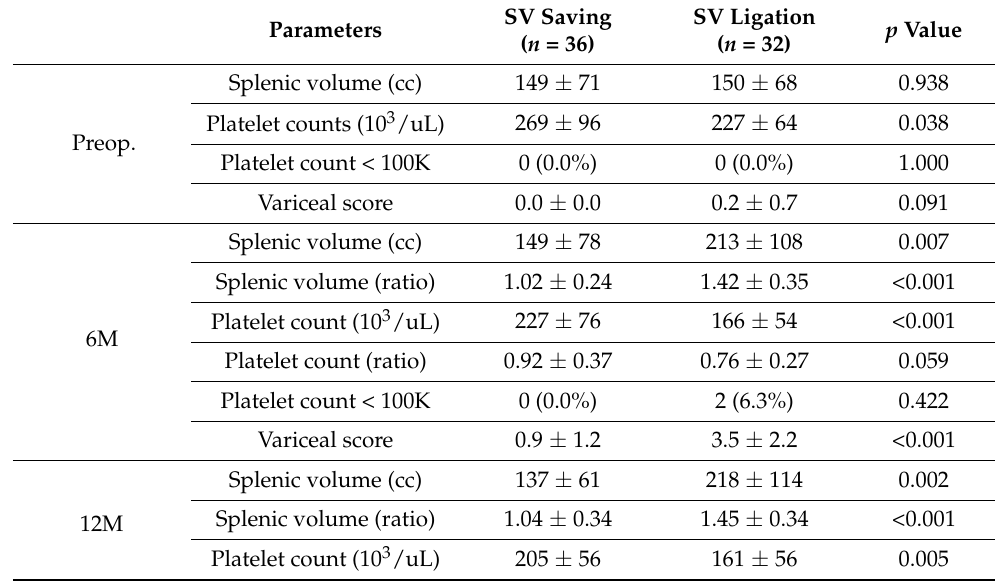
Table 4. Pre- and postoperative changes in variceal-related